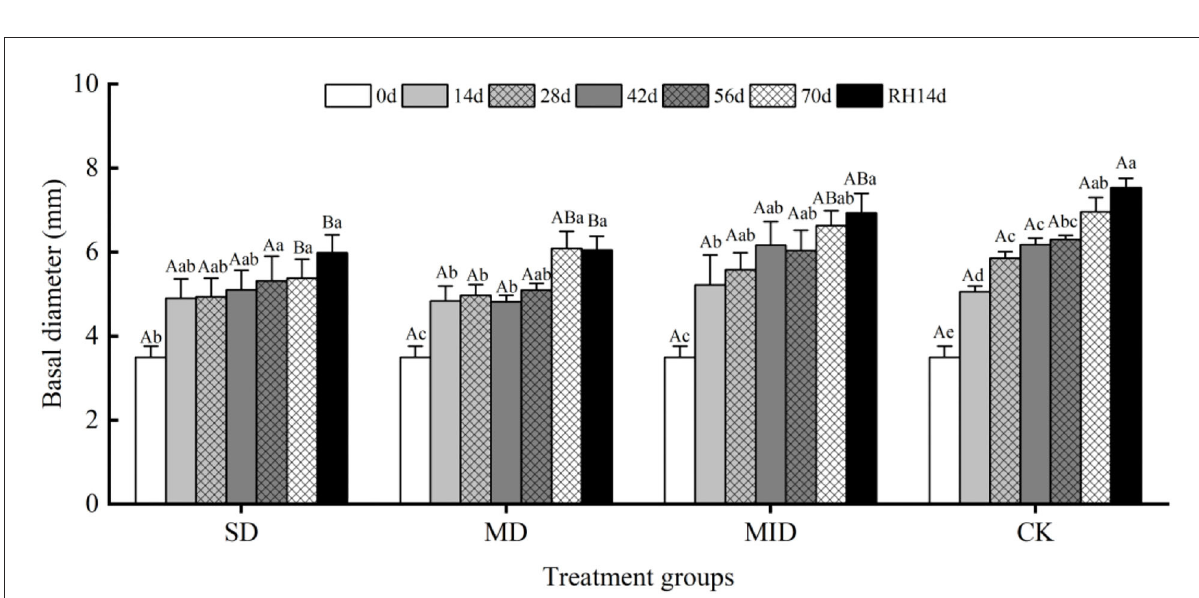
FIGURE4 The basal diameter during the drought and rehydration for A. selengensis . 0 day, 14 days, 28 days, 42 days, 56 days, 70 days, and RH, 14 days respectively represent 0th, 14th, 28th, 42nd, 56th, 70th under drought and 14th day of rehydration. The severe drought group (SD), the moderate drought group (MD), the mild drought group (MID), the control group (CK). Different capital letters stand for significant differences between different drought groups ( p < 0.05), and different lowercase letters stand for significant differences between different experimental times ( p <